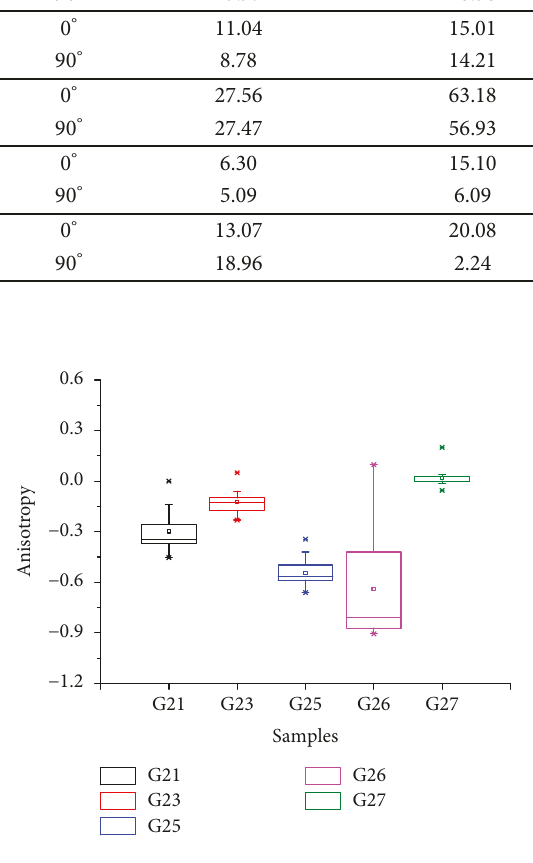
Figure 6: Pressure anisotropy of fracture samples F1 – F5.